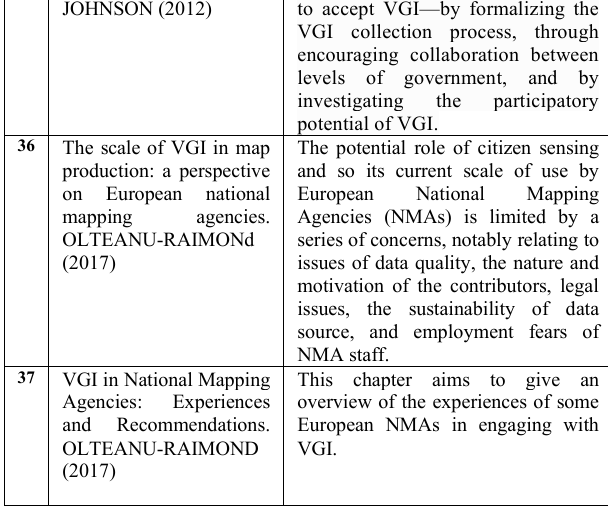
Table 3: Publications and relevant context in the integration